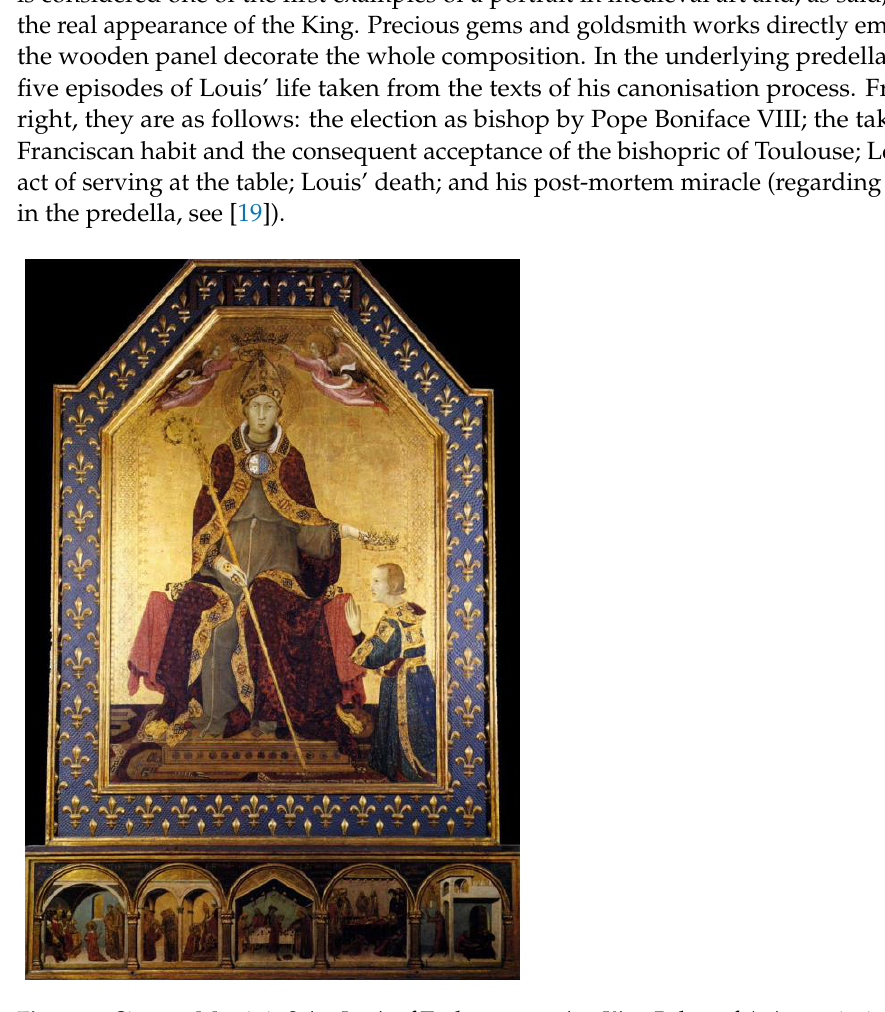
Figure 2. Simone Martini, Saint Louis of Toulouse crowning King Robert of Anjou , painting on wood, 1317–1319. Naples, Museo di Capodimonte. Source: public domain image. 1317–1319. Naples, Museo di Capodimonte. Source: public domain